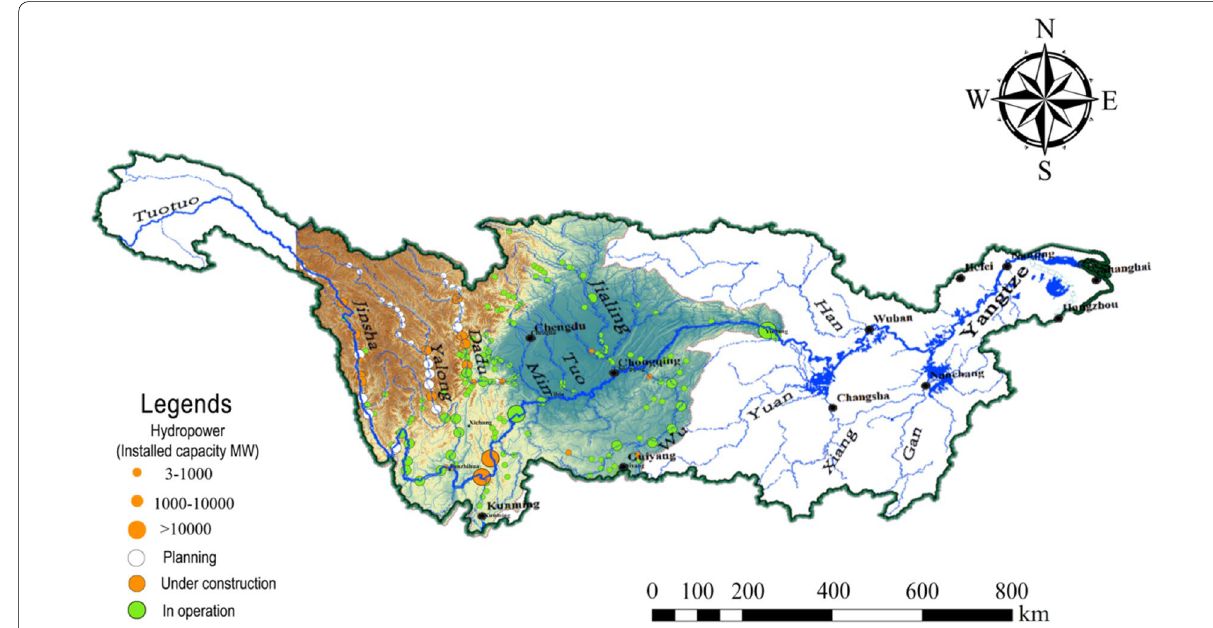
Fig. 1 Schematic diagram of the Yangtze River Basin in China, and the large-scale hydropower plants in the upper Yangtze River